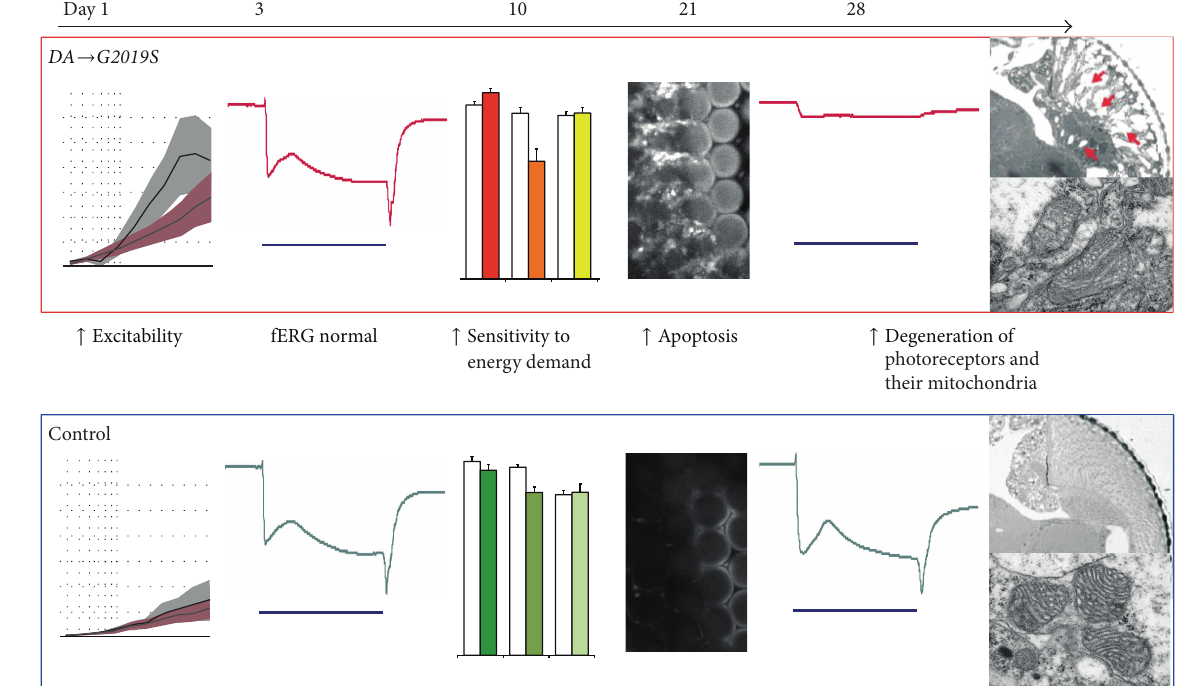
Figure 5: An excitotoxic cascade is initiated by the dopaminergic expression of the human LRRK2-G2019S transgene ( DA → G2019S ). In young, 1-day-old DA → G2019S flies, the eyes show much greater contrast sensitivity than the controls. At 3 days, the visual sensitivity measured by a flash electroretinogram (fERG) is indistinguishable from control flies. At 10 days, the DA → G2019S flies are more sensitive to energy demands than controls. Energy demand is increased by either treatment with flashing light or knockdown of potassium channels. By 21 days, the DA → G2019S eyes show evidence of apoptosis (anticleaved-caspase-3 staining). Old flies, 28 days, show little photoreceptor response, extensive vacuoles, and deformed mitochondria, showing loss of both function and structure. Data and exact genotypes in [15,